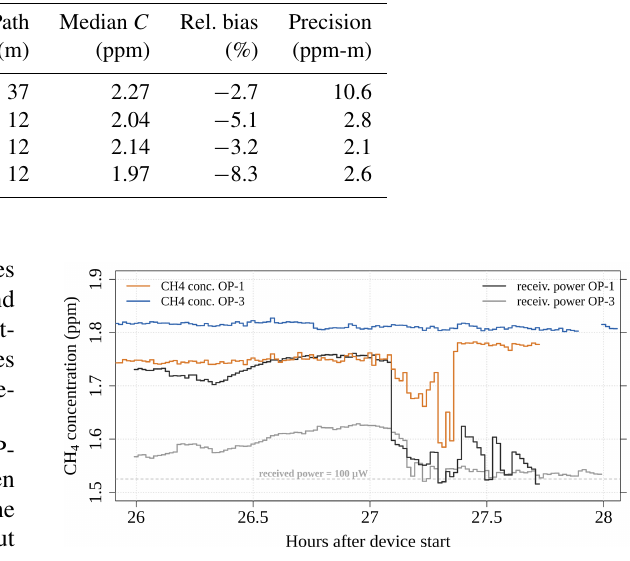
Figure 4. Example of a concentration dent followed by a step change related to losses in the received power of device OP-1. The data were recorded during the intercomparison campaign K19 on 26 April 2019 between 02:00 and 04:00CET. From hour 27 on- wards, the data exhibit R2 values above